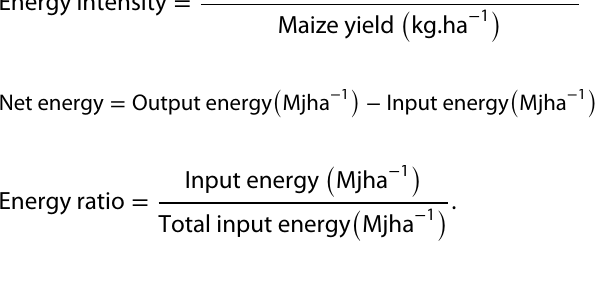
ppm part per million, dsm −1